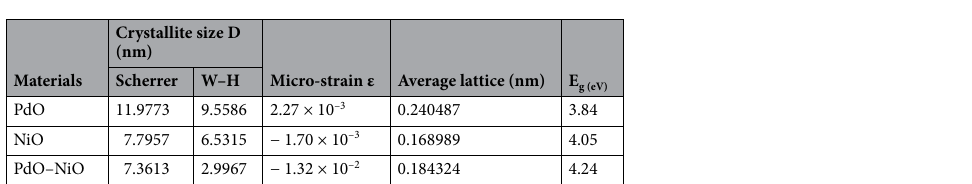
Table 1. Crystallite sizes, d-spacing, micro-strains, and binding energies of the PdO, NiO, and PdO–NiO.